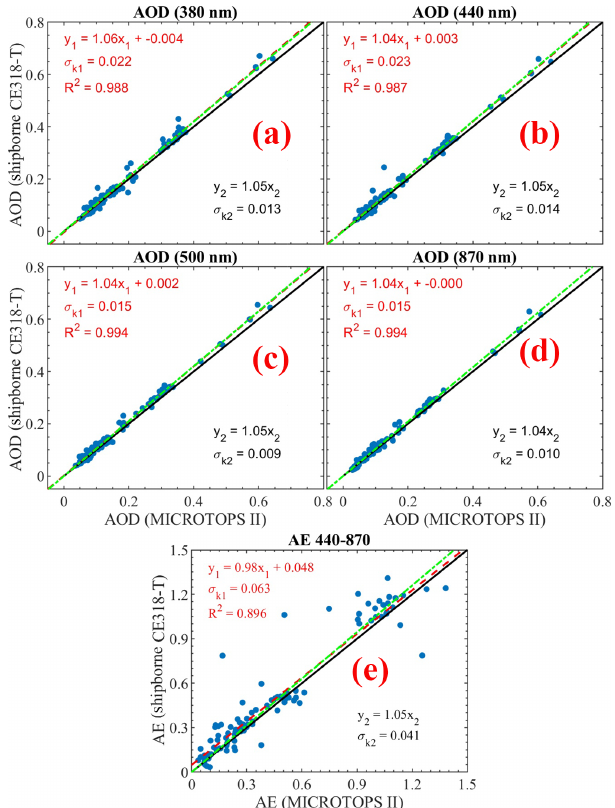
Figure 4. Linear regression of AOD (a, b, c, d) and Ångström ex- ponent (e) from the shipborne CE318-T and MICROTOPS II ob- servations. The data points are mean values within a sliding win- dow of 20min. Overall, 115 data pairs are used in this regression. The dashed red line is the regression result with free intercept re- lationship and the dot–dashed green line represents the regression relationship with forced intercept through